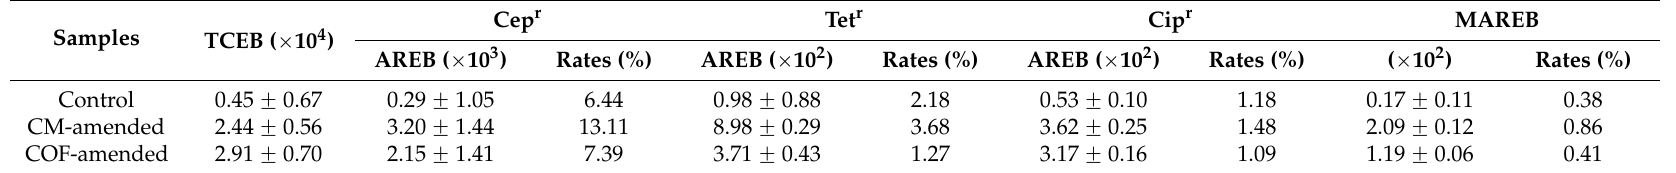
Table 2. Concentrations and rates of AREB and MAREB in pot-grown pakchoi (CFU ¨ g ´ 1 ).